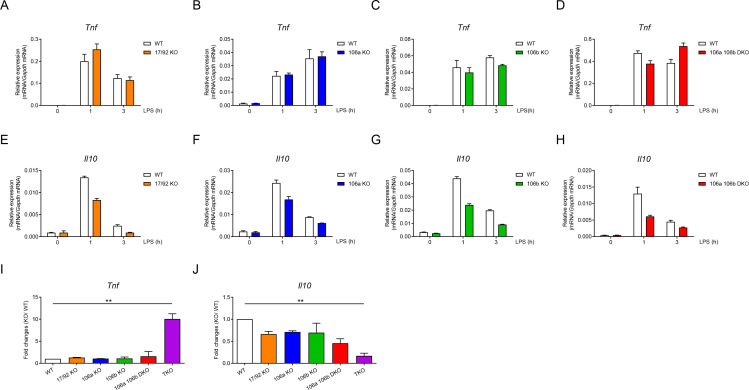
Three clusters of miR-17~92 family miRNAs regulate the expression of TNF and IL-10 collectively in macrophages.(A–D) qPCR analysis of Tnf mRNA in WT and miR-17~92flox/flox
Lyz2-Cre (17/92 KO) (A), miR-106a~363−/− (106a KO) (B), miR-106b~25−/− (106b KO) (C), or miR-106a~363−/− miR-106b~25−/− (106a 106b DKO) (D) BMDMs stimulated for the indicated periods with LPS. (E–H) qPCR analysis of Il10 mRNA in WT and 17/92 KO (E), 106a KO (F), 106b KO (G), or 106a 106b DKO (H) BMDMs stimulated for the indicated periods with LPS. (I and J) qPCR analysis of Tnf (I) and Il10 (J) mRNA in WT and various knockout (horizontal axes) BMDMs stimulated for 1 hr with LPS; results are presented relative to those of LPS-stimulated WT BMDMs. **p<0.01 (paired Student’s t-test). Data are representative of two (A–C and E–G) or three (D and H) independent experiments or are pooled from two to three (I and J) independent experiments (mean + s.d.).